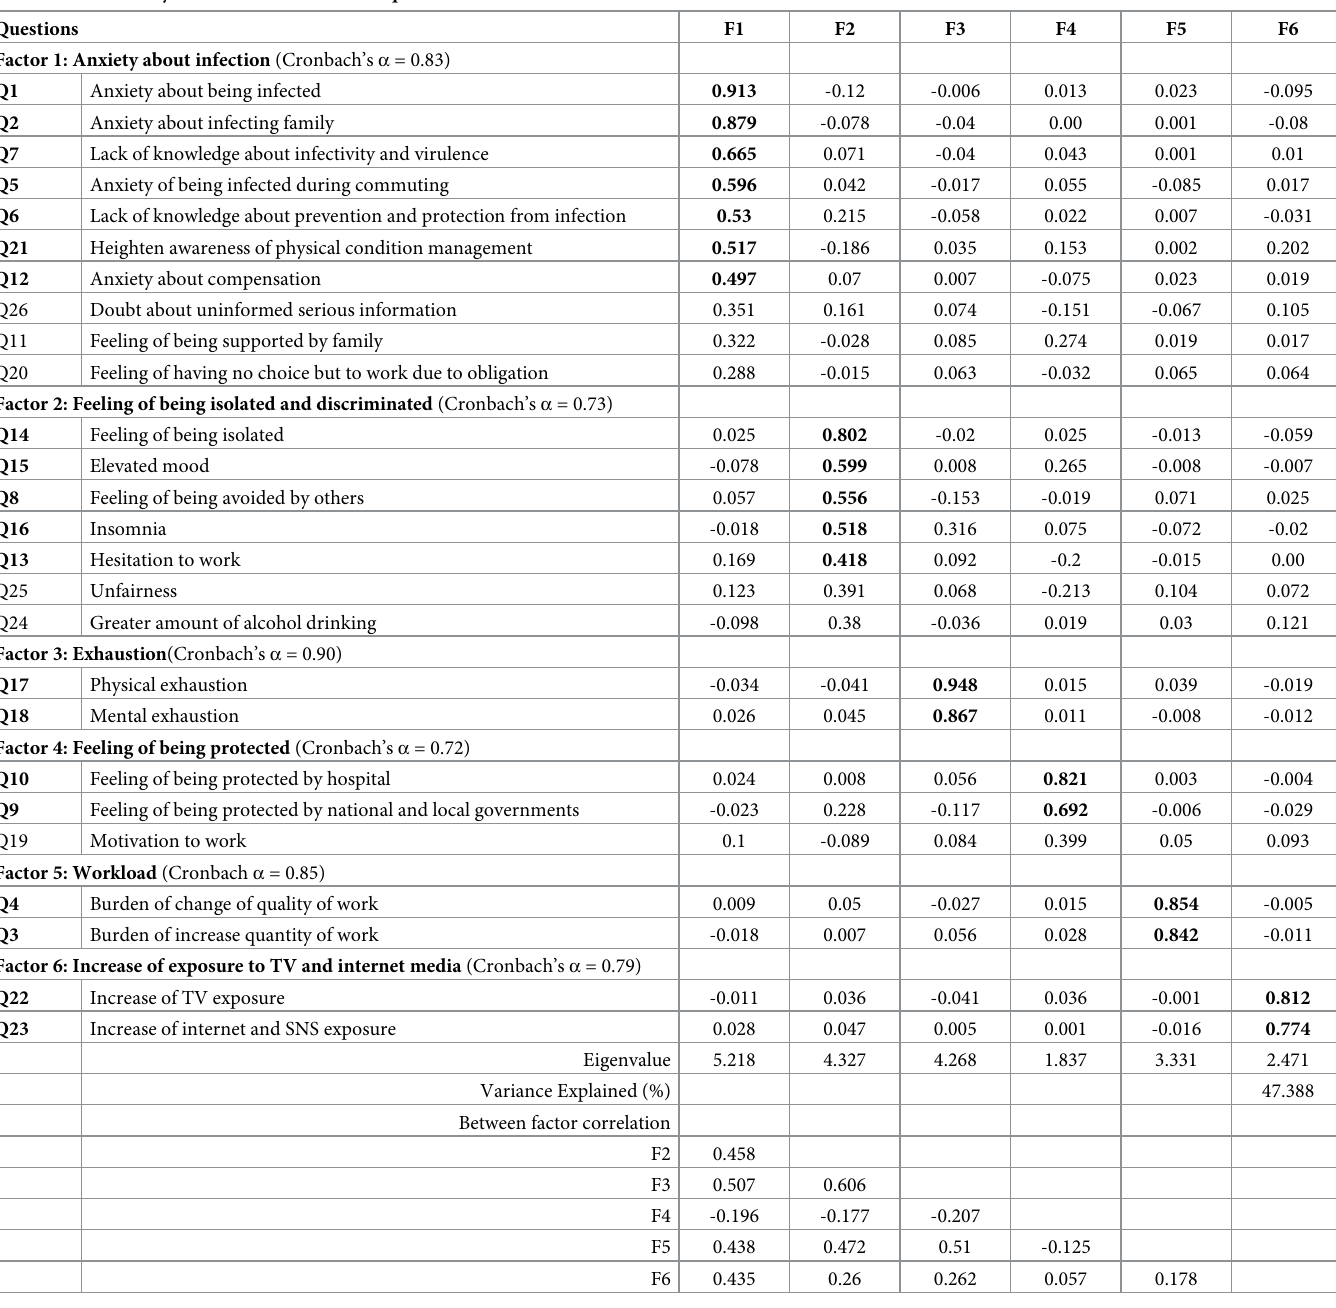
Table 3. Factor analysis of the 26 stress-related